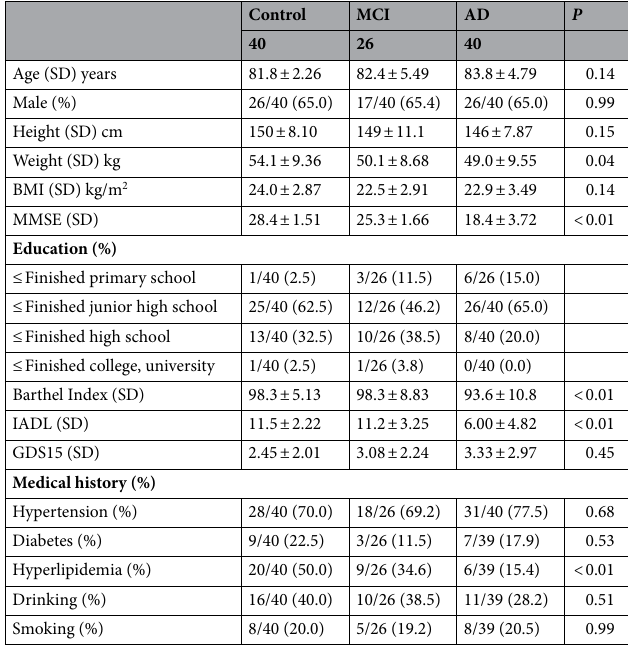
Table 1. Participant characteristics. BMI body mass index, MMSE Mini Mental State Examination, IADL instrumental activities of daily living, GDS15 geriatric depression scale